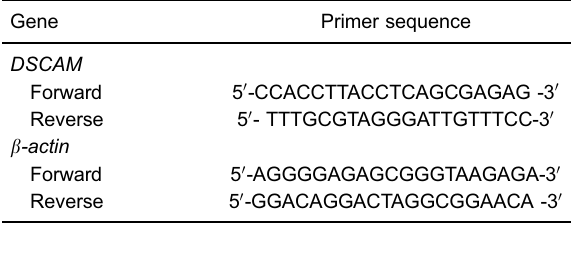
Figure 1. Morris water maze probe trial param- eters of amyloid precursor protein transgenic mice (Tg) and age-matched wild-type littermates (WT) (n=16/group). Data are reported as means ± SD. *P o 0.05, **P o 0.01 vs 6-month-old Tg mice, # P o 0.05 vs 6-month-old WT mice (ANOVA followed by least signi fi cant difference t -tests for pair-wise